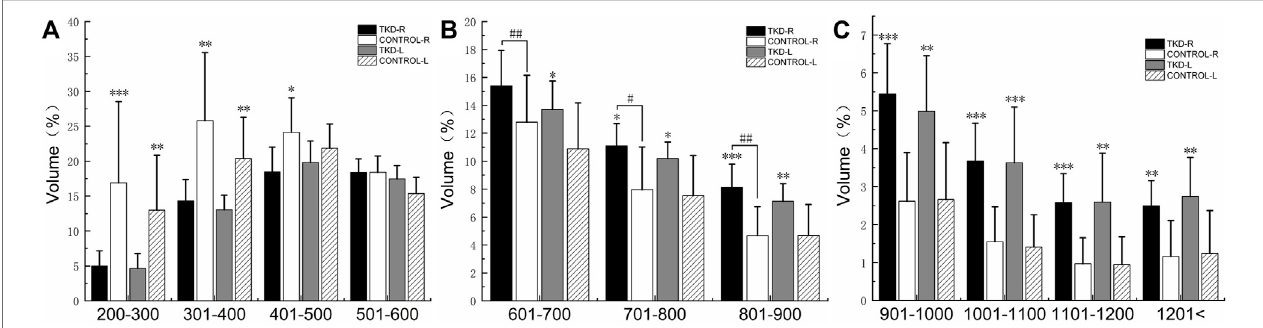
FIGURE 5 | Comparison of the bone volume of each bone density zone in the distal tibia subchondral bone between the groups (%). (A) is the bone volume of low bonedensity; (B) isthebonevolumeofmediumbonedensity; (C) isthebonevolumeofhighbonedensity(***,**,and*indicatestatisticallysigni fi cant p valuesof < 0.001, < 0.01, and < 0.05 vs. control group; ## and # indicate statistically signi fi cant p values of < 0.01 and < 0.05 in Taekwondo in vivo, respectively).